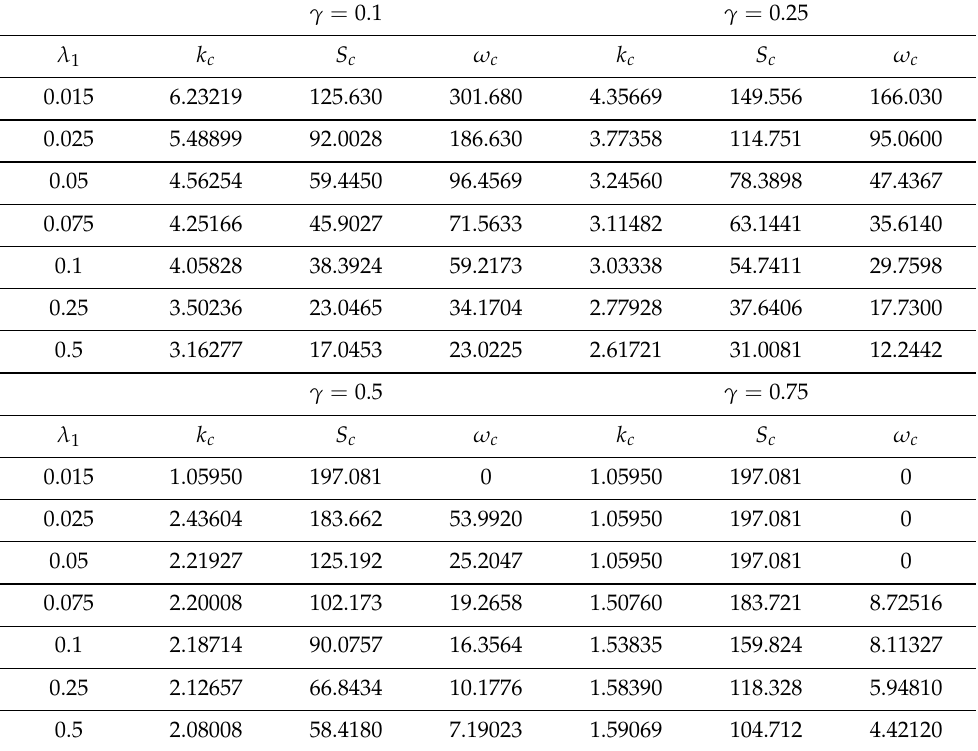
The threshold values of k , S , ω that have been found numerically are reported in Table 1. The obtained results ( k c , S c ) are insensitive to the sign of ω c . Thus, in Table 1, the values of ω c are to be intended as | ω c | . As can be inferred from Table 1, for a given value of γ , an increase in the dimensionless relaxation time λ 1 leads to a decrease in the threshold values k c , S c , ω c (at least, whenever ω c (cid:54) = 0). The minimum ( k c , S c ) of the neutral stability curve moves to the left and becomes smaller. Table 1. Critical values of ( k , S , ω ) versus λ 1 , γ . γ = 0.1 γ =